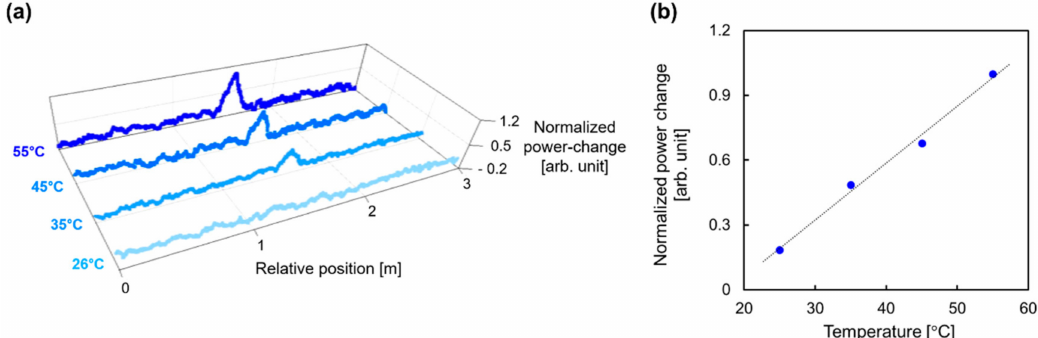
Figure 16. ( a ) Normalized power-change distributions along a POF measured at four temperatures. ( b ) Maximal power-changes plotted as a function of temperature. The dotted line is a linear fit. Reproduced with permission from [61]. Copyright (2016)